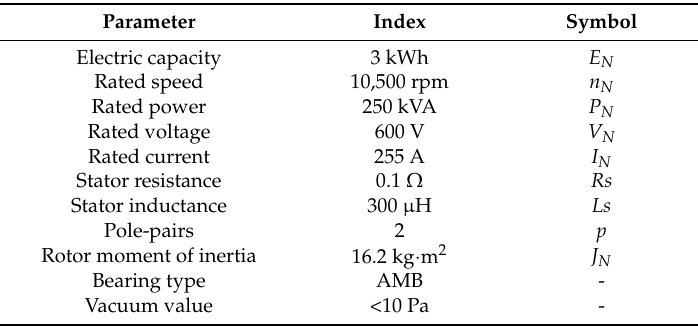
Figure 5. Experimental setup. UPS: unterruptible power supply. Table 1. MSFESS